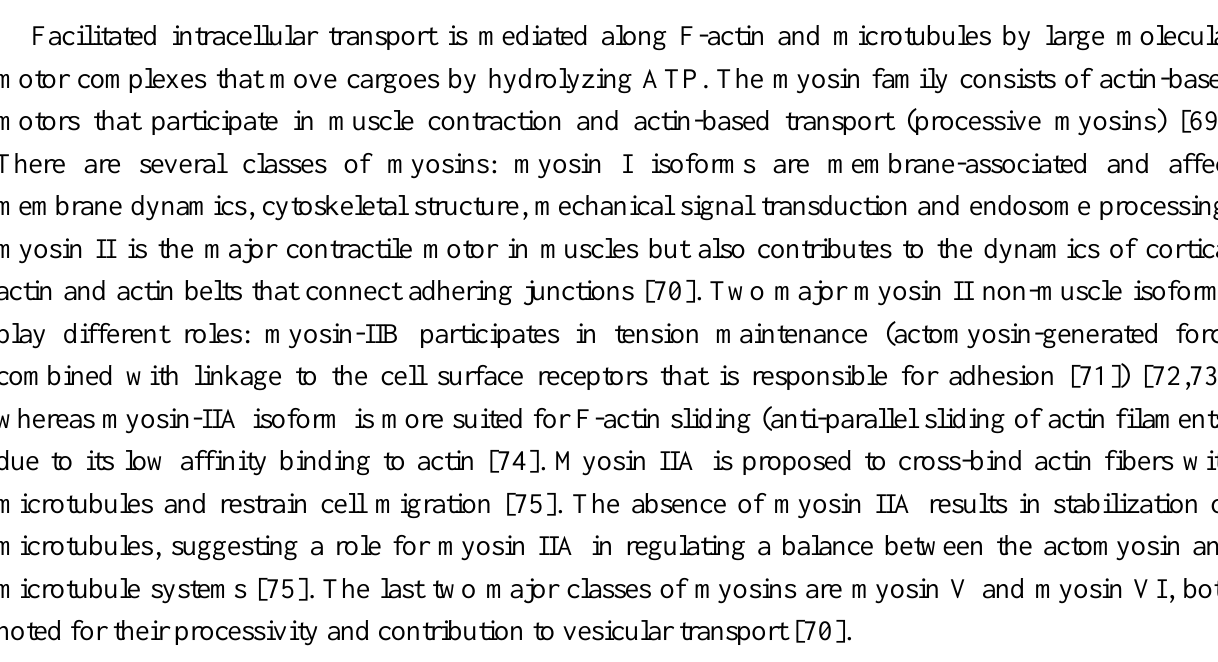
Figure 2. Alphaherpesvirus intracellular transport, dissemination, and